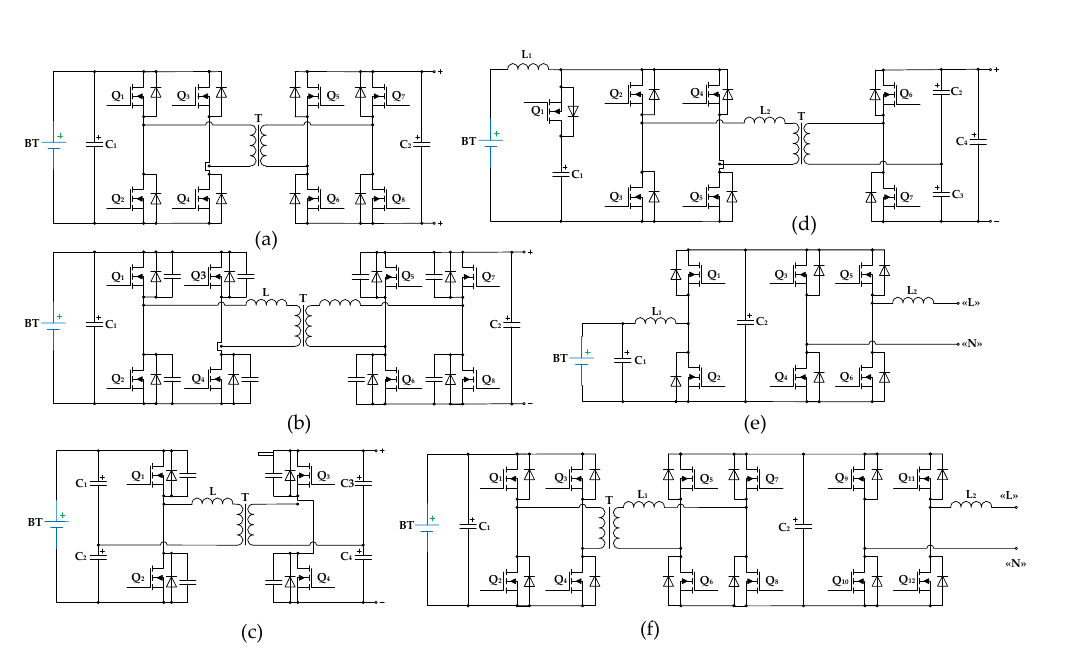
Figure 14. Converters for single-stage storage applications: ( a ) half-bridge; ( b ) Cuk’; ( c ) SEPIC/Luo; ( d ) interleaved half-bridge; ( e ) cascaded half-bridge; ( f ) half-bridge rectifier with neutral point switch clamped scheme; ( g ) capacitor clamped three-level; ( h ) high-frequency-link inverter.